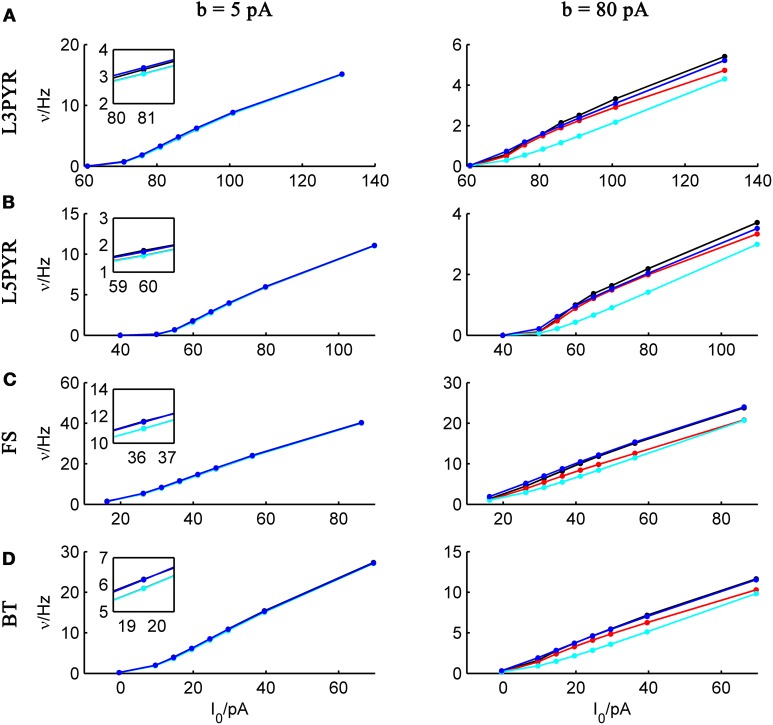
Comparison of theoretical and simulated ν-I curves for small and large spike-triggered adaptation. The ν-I curves for a simulated (A) layer-3 pyramidal cell, (B) layer-5 pyramidal neuron, (C) fast-spiking, and (D) bitufted interneuron (averaged model parameters given in Table 1) are shown in black and compared to the theoretical predictions (ν0: in cyan, ν0 + ϵ2 ν2: in blue, 〈 νEIF 〉w: red) for small (left panel, b = 5 pA) and large b (right panel, b = 80 pA). μIsyn ∈ {r − 20, r − 10, r − 5, r, r + 5, r + 10, r + 20, r + 50} pA with r denoting the cell-specific rheobase, σIsyn = 150 pA. Insets show zoom-ins on the firing rate at the rheobase.